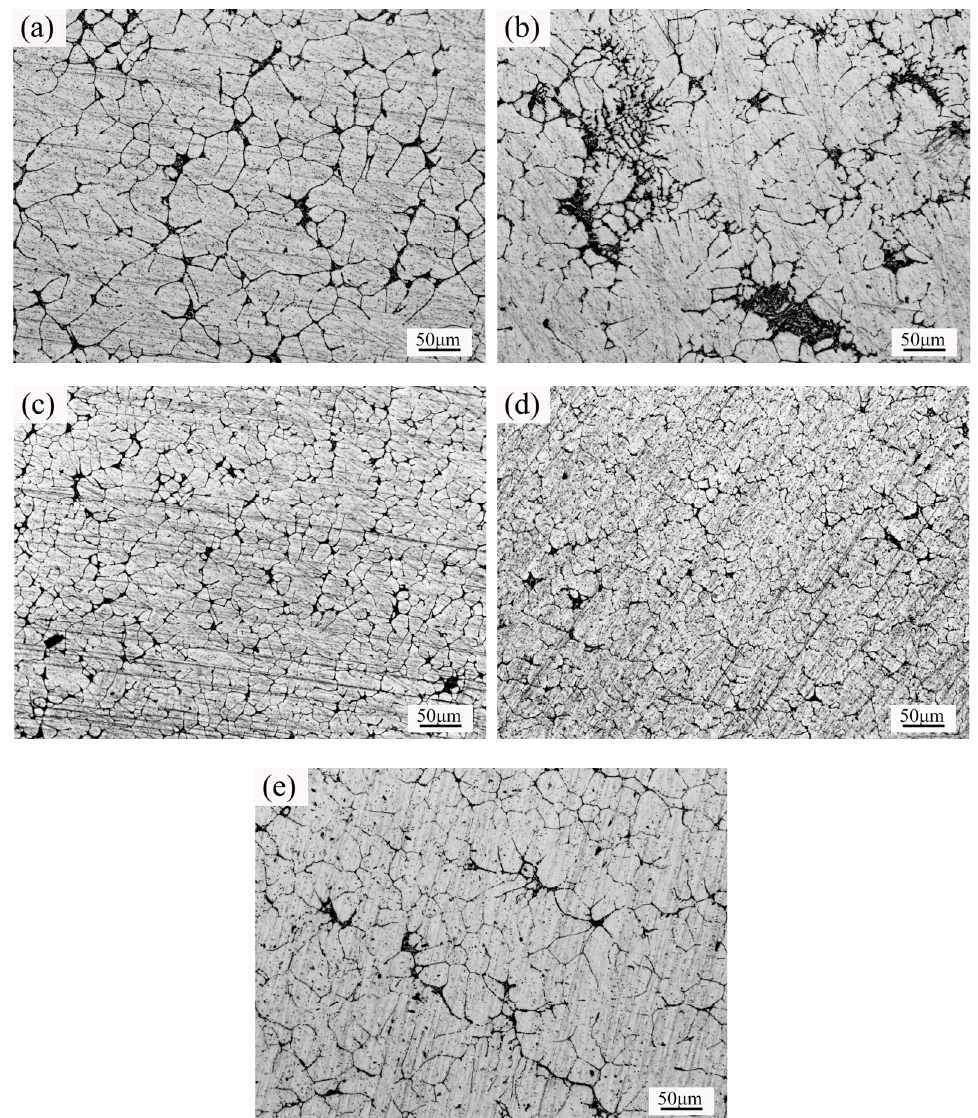
Figure 9. Metallographic photographs of the samples at different mold pre-heating temperatures: ( a ) 100 °C; ( b ) 150 °C; ( c ) 200 °C; ( d ) 250 °C; ( e ) 300 °C.